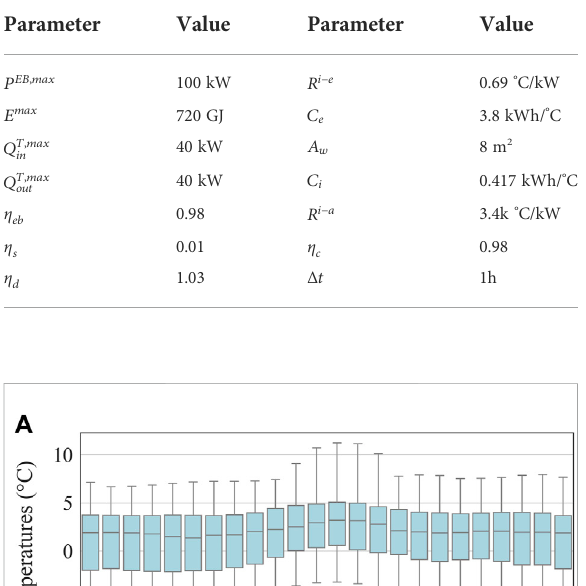
TABLE 1 Parameters of DHS.